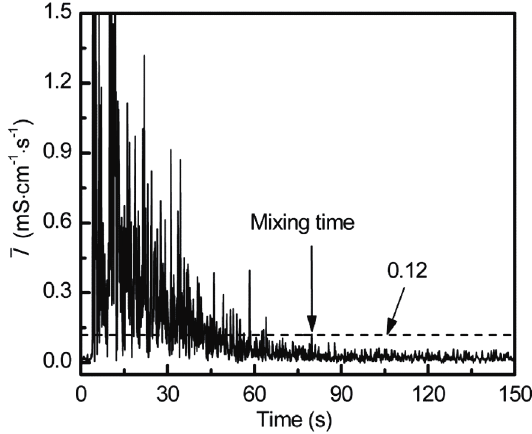
Fig. 2: Schematic of the arrangement of probes and tracer injection locations at shaking ladle bottom